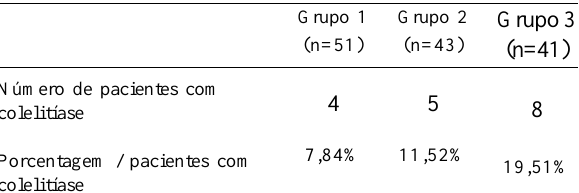
Tabela 3. Prevalência de